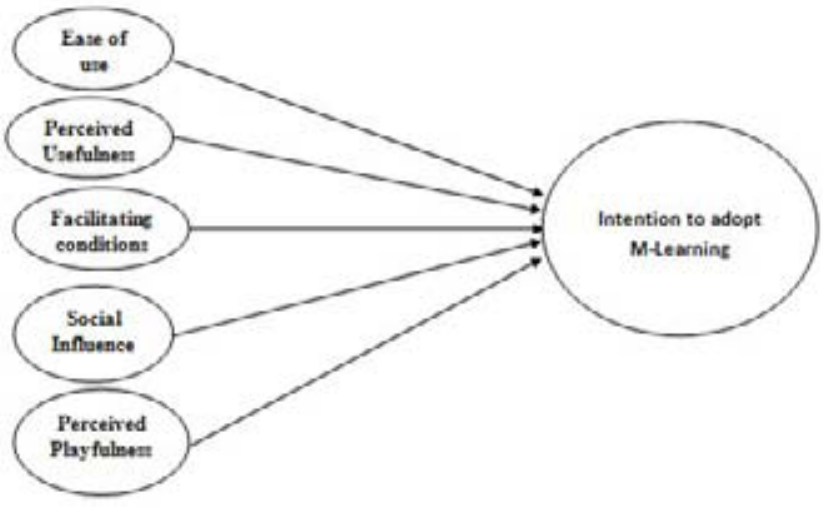
Figure 1. Graphical sketch of theoretical